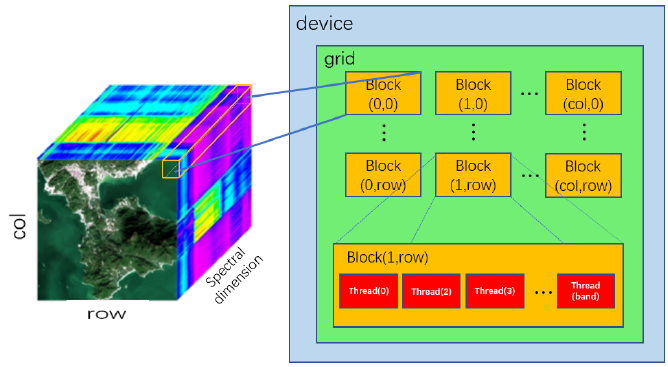
Figure 2. Schematic diagram of our threads organization for performing noise estimation.